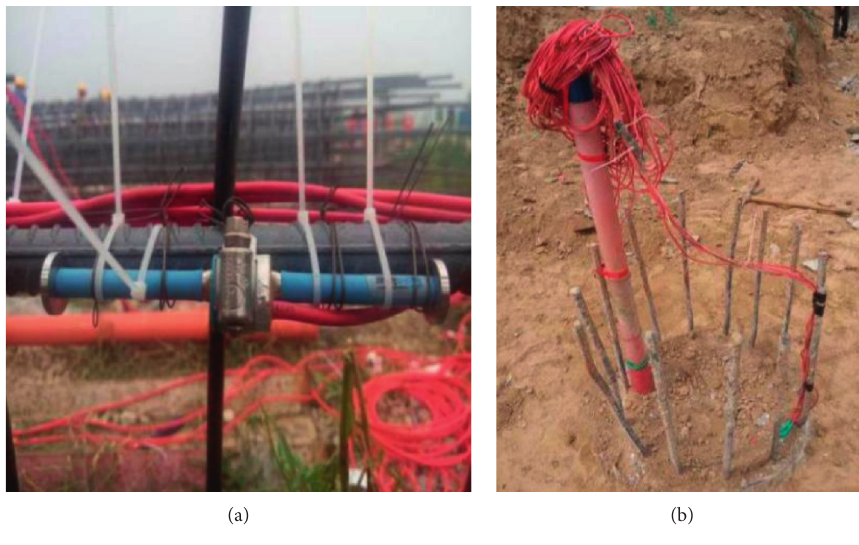
Figure 12: Binding and burial of strain